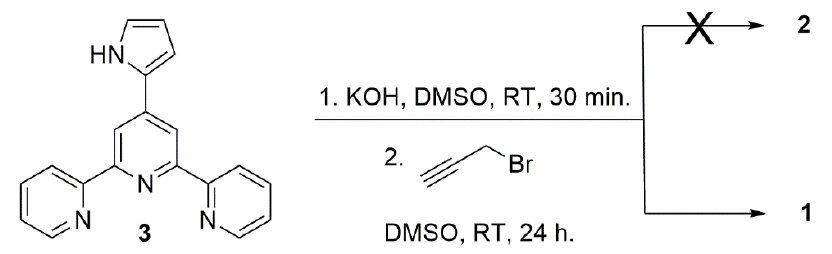
Figure 2. Synthetic pathway that afforded compound 1 .